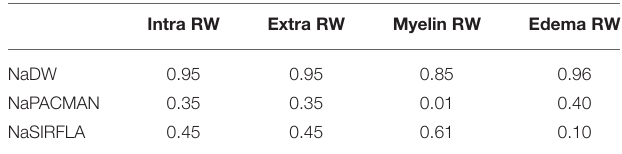
TABLE 2 | Relaxation weighting (RW) of each sequence (i.e., signal relative to 1) for four different 23 Na environments determined according to Supplementary Section 4.4.2